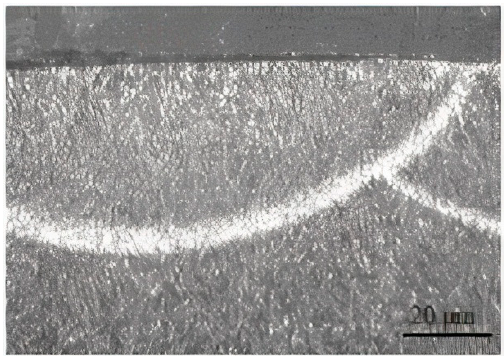
Figure 2. Microstructure of the steel specimen with laser borided surface layer.